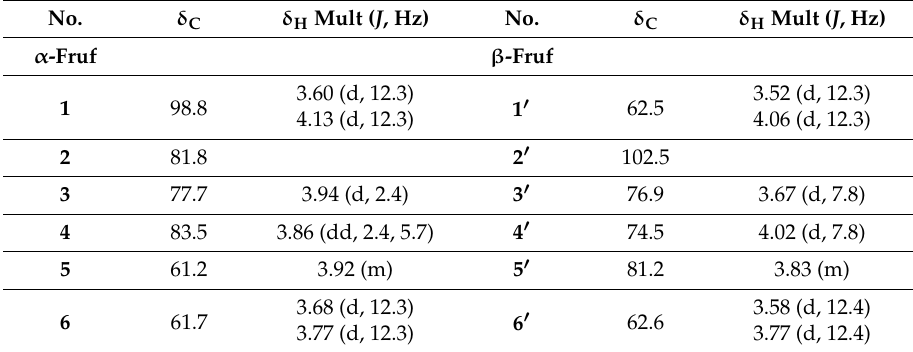
Table 2. The 1 H- and 13 C-NMR data of compound 3 (D 2